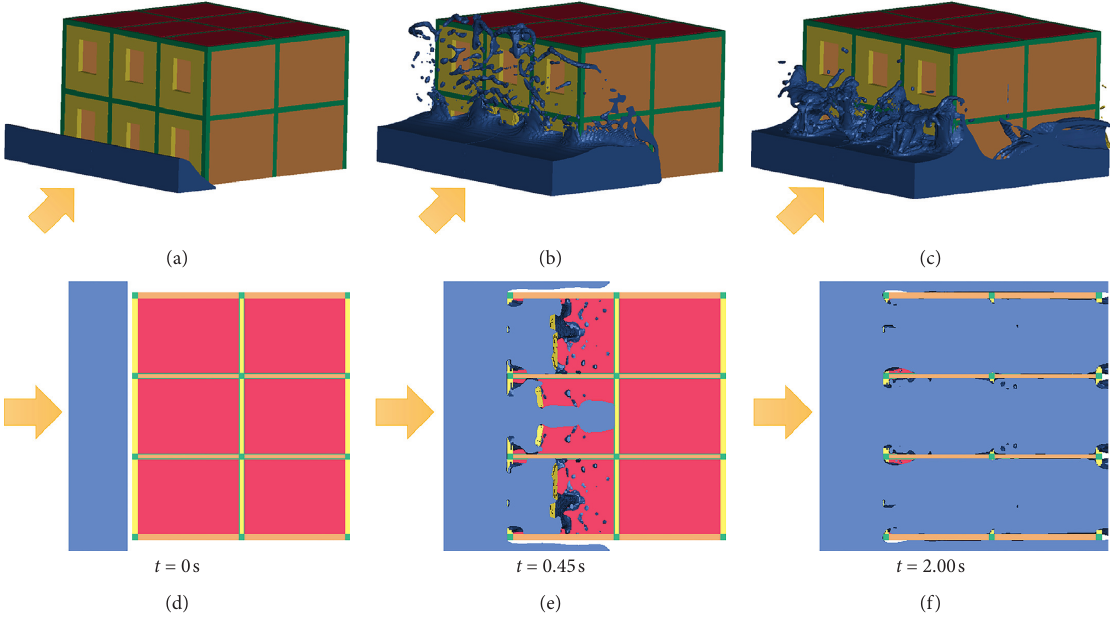
Figure 6: Snapshots in the scenario of s � 1, h � 1.6m, and v � 8.0m/s: (a–c) oblique view, and (d–f) bottom